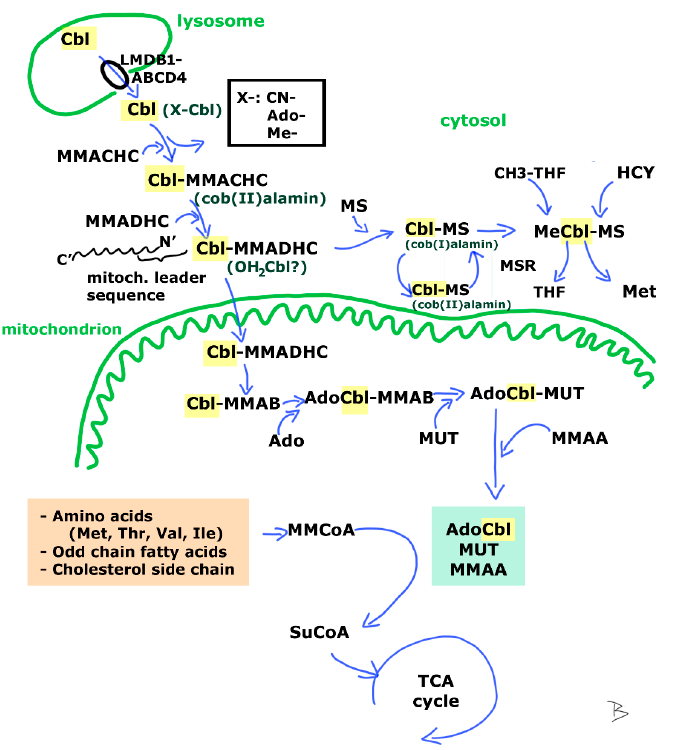
Figure 3. Intracellular Cbl processing. After leaving the lysosome via the LMDB1-ABCD4 complex, the Cbl in cytoplasm might be linked to various ligands (X-). During processing by MMACHC, ligand “X-“ is removed and the generated cob(II)alamin is further oxidized by MMADHC. This latter contains an N’-terminal mitochondrial leader sequence and is capable of directing the attached Cbl either to the cytoplasm, or to the mitochondria. In the cytoplasm the complex donates Cbl to MS that becomes capable for receiving the Me-group of CH3-THF and converting HCY to Met. The active form of MeCbl-MS contains cob(I)alamin that might spontaneously oxidize to cob(II)alamin